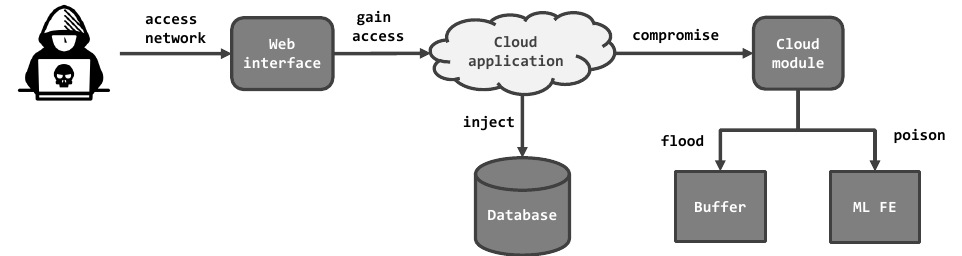
Figure 4. Overview of possible attack scenarios against a cloud-based